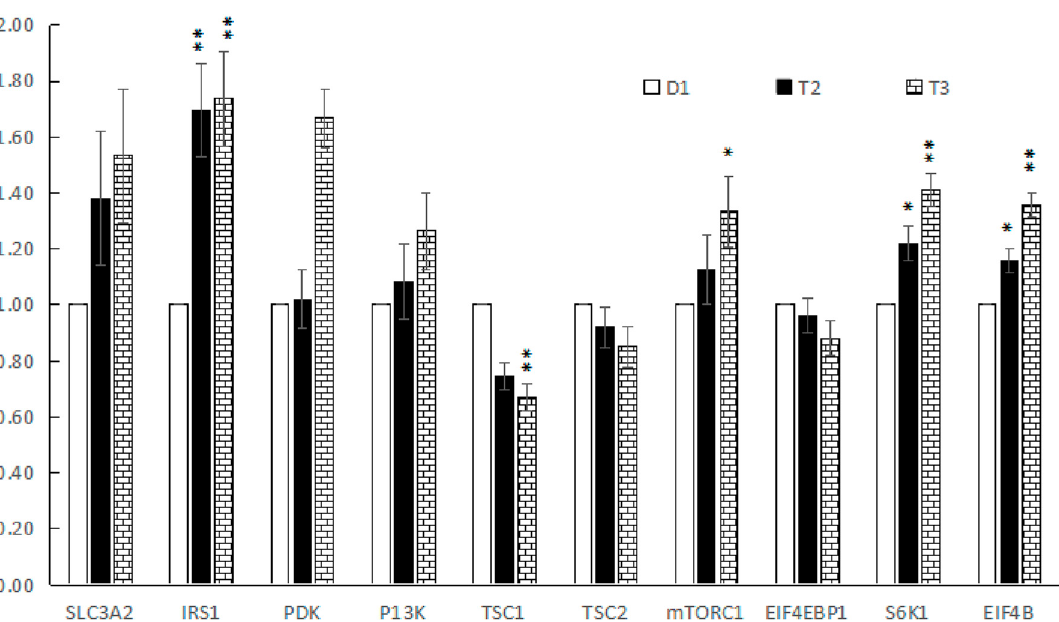
Figure 2. The relative expression levels of SLC3A2, IRS1, PDK, P13K, mTORC1, eIF4EBP1, S6K1, and eIF4B mRNA in liver. Control group (D1), low protein with low RPAA (T2), low protein with high RPAA (T3). SLC3A2 = Solute carrier family 3 (amino acid transporter heavy chain), member 2; IRS1 = Insulin receptor substrate 1; PDK = Phosphoinositide-dependent protein kinase; P13K = Phos- phoinositol 3-kinase; TSC1 = Tuberous sclerosis complex 1; TSC2 = Tuberous sclerosis complex 2; mTORC1 = Mammalian target of rapamycin complex 1; S6K1 = Ribosomal protein S6 kinases; eIF- 4B = Eukaryotic initiation factor. *: The difference is significant. **: The difference is extremely sig- nificant.